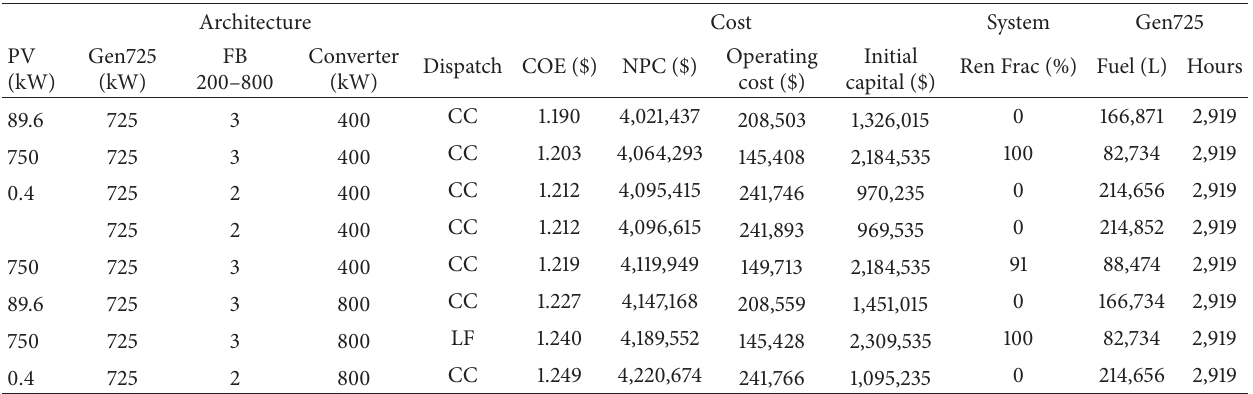
Table 6: HOMER simulation result showing optimization case with overall option.